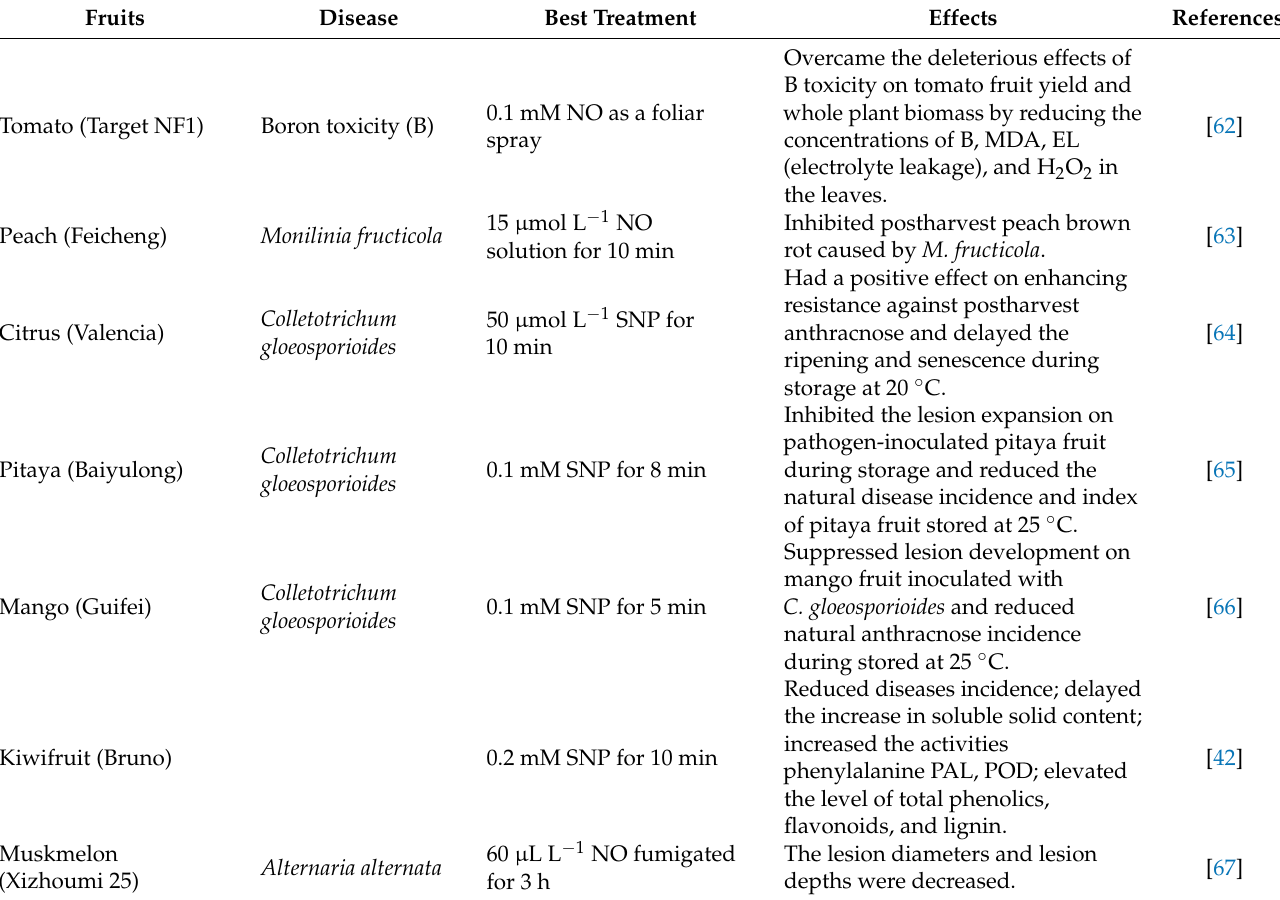
Figure 4. NO treatment enhanced peach fruit resistance to Monilinia fructicola [61]. © 2023 Yu, Cao, Zhu, Zhang, Peng and Shi. Table 3. The effects of NO on disease and disorder resistance.